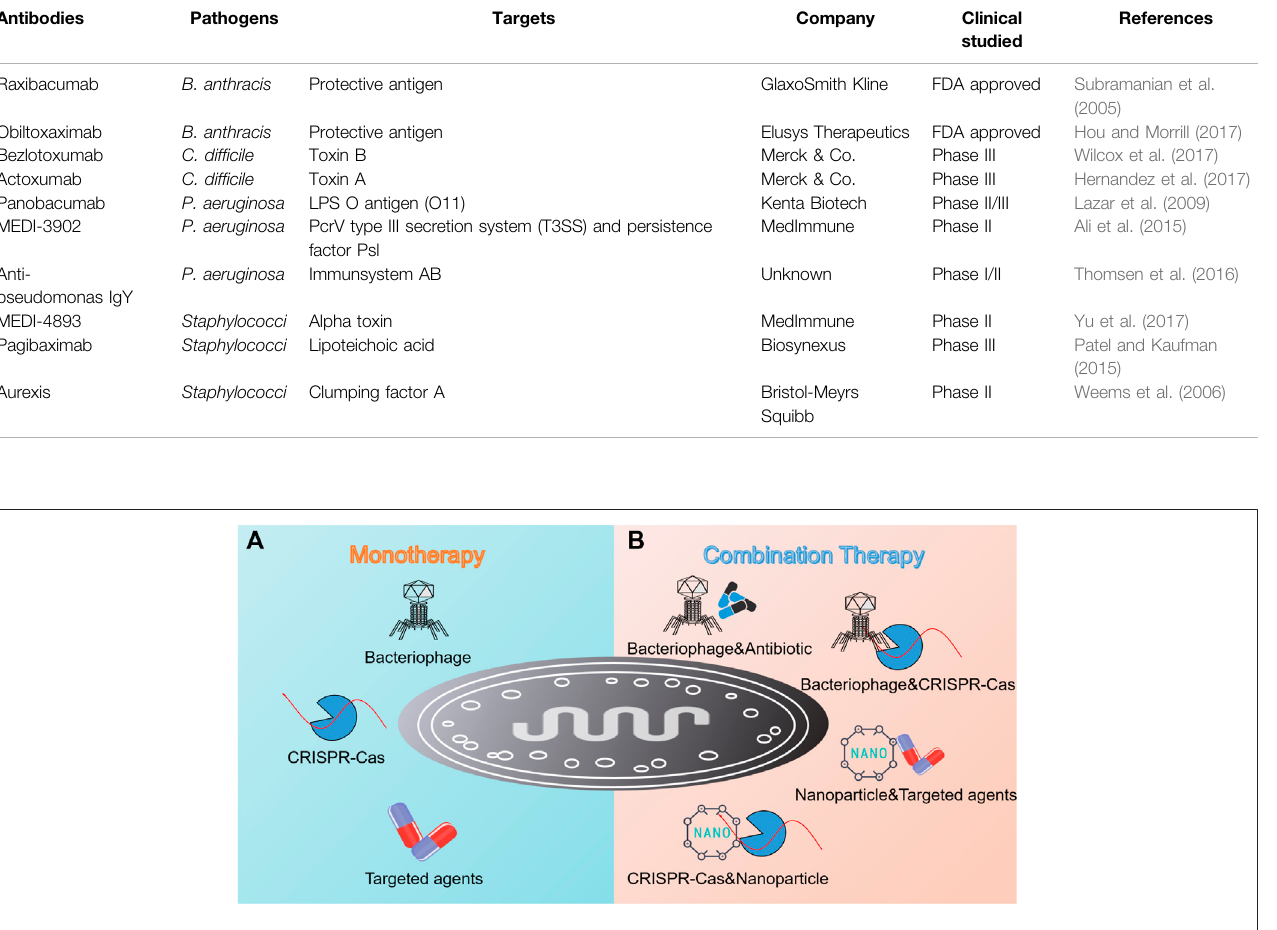
Frontiers in Pharmacology |